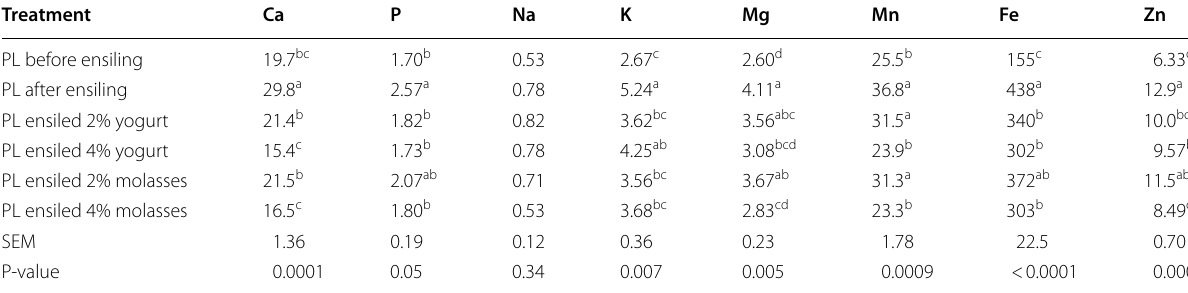
Means within columns followed by the same letter are not different PL pomegranate leaves, Ca (g/kg DM) calcium, P (g/kg DM) phosphorus, Na (g/kg DM) sodium, K (g/kg DM) potassium, Mg (g/kg DM) magnesium (g/kg DM), Mn (mg/kg DM) manganese, Fe (mg/kg DM) iron, Zn (mg/kg DM) zinc SEM standard error of the mean